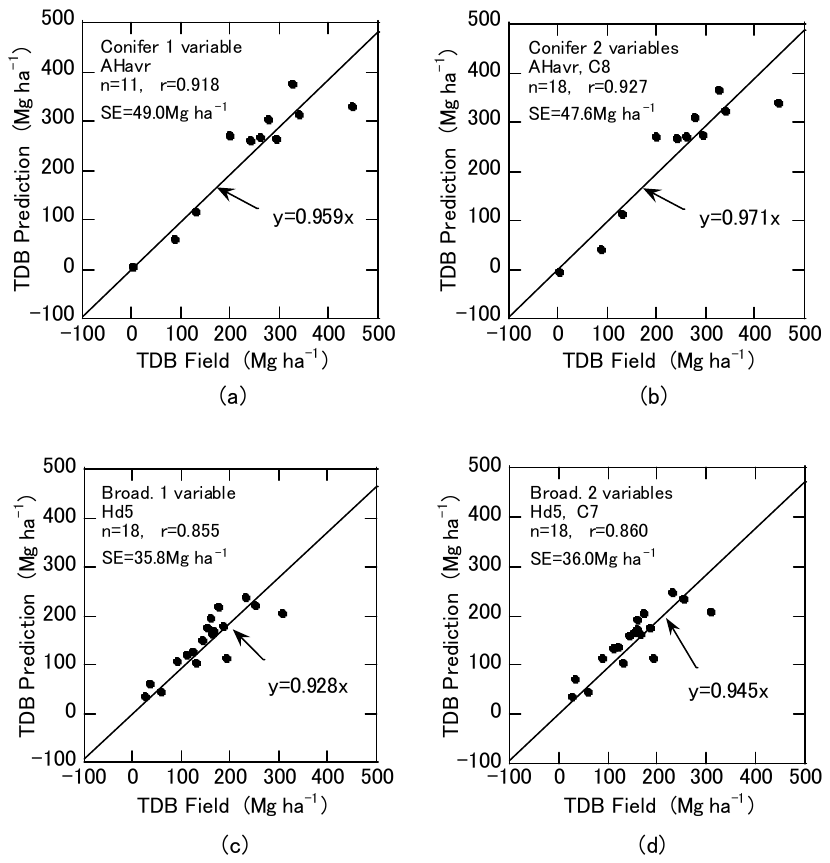
Figure 6. Validation results of TDB prediction based on the comparison of predicted and field TDB. ( a ) One- and ( b ) two-variable models for evergreen conifer forests, and ( c ) one- and ( d ) two-variable models for deciduous broadleaved forests.